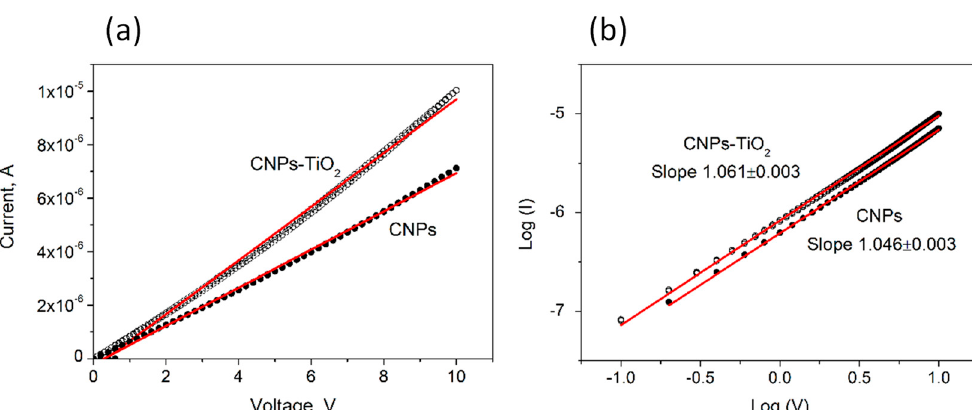
Figure 4. ( a ) IV characteristics in the interval [0 V, +10 V] for the CNP film (filled circles) and the CNP-TiO 2 film (empty circles). The linear best fit of the data is also shown. ( b ) The log ( I ) vs. log ( V ) trend and the respective linear best fits.